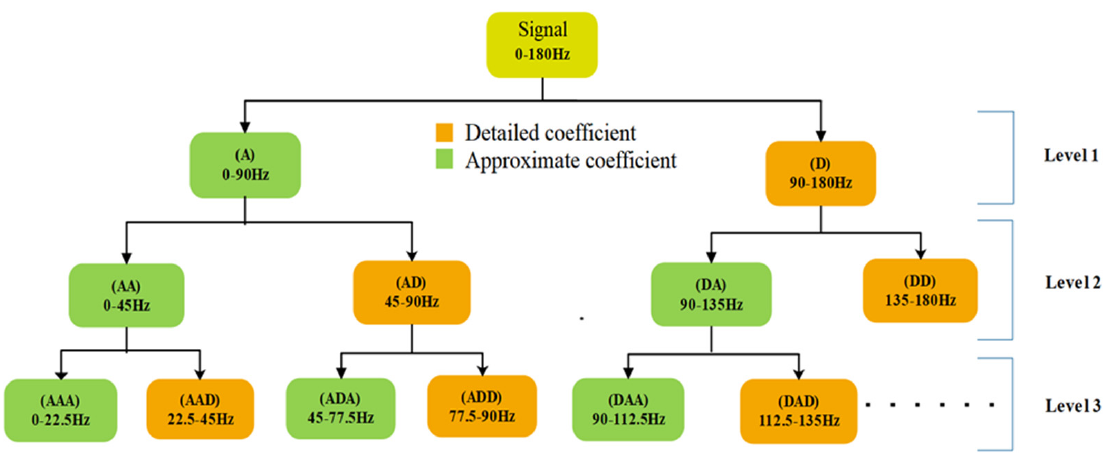
Figure 3. Different nodes of the WPD tree (level-3) with their frequency range.